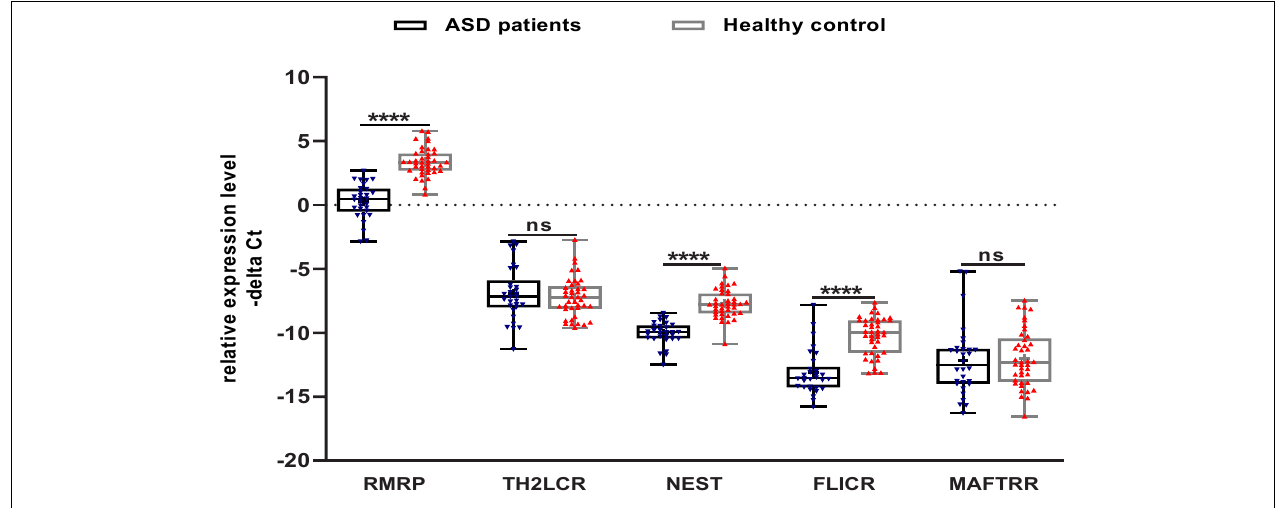
FIGURE 1 | Relative expressions of five Treg-related genes RMRP, TH2LCR, NEST, and FLICR genes in patients with ASD (total) and healthy controls (total) as designated by –delta Ct values. –Delta Ct data were plotted as box and whisker plots. Median, mean, and interquartile ranges are shown. Unpaired t -test or non-parametric test (Mann–Whitney U test) was used to identify differentially expressed genes between two groups (**** P -value < 0.0001; ns, non-significant).